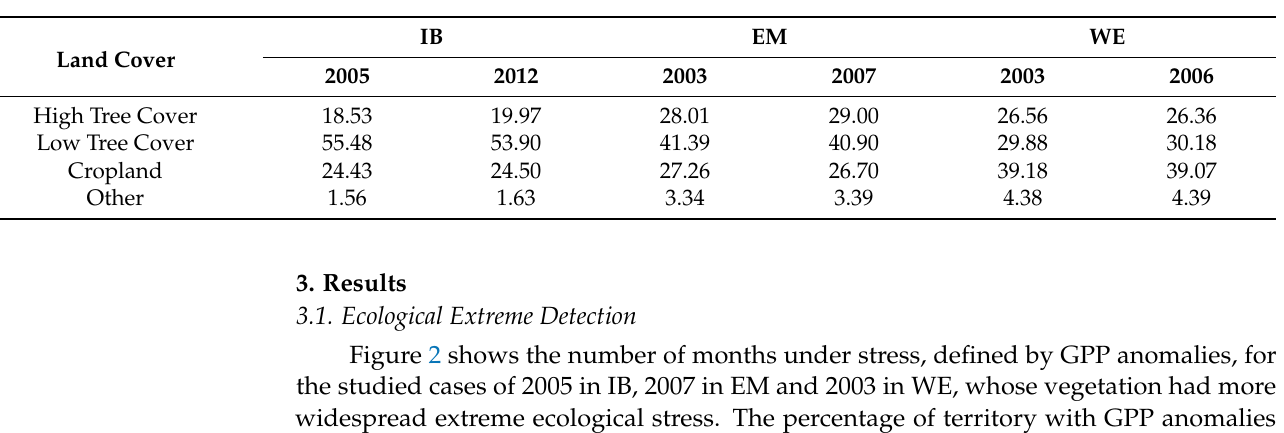
Table 2. Percentage area cover by the 4 main land cover types in the years of the selected extreme episode for the three studied